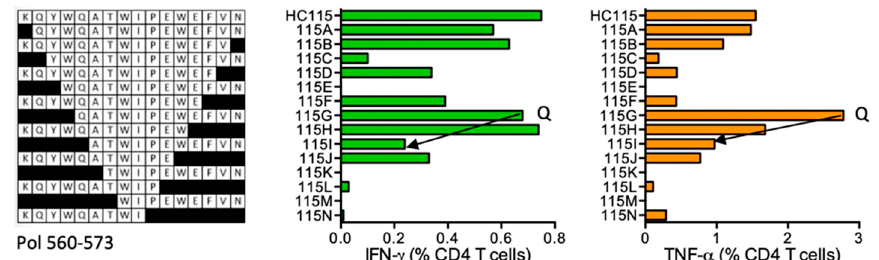
Figure 13. HC115 / VID 414—definition of CD4 + T-cell epitopes in HIV-1 protein Pol. HC115-grown SCTL from subject 414 was stimulated with progressively truncated peptides (left) in an ICS assay and production of IFN- γ (green) and TNF- α (orange) by CD4 + T cells was measured by flow cytometry. Arrows in the graph and amino acid Q indicate the stimulatory peptide termini.